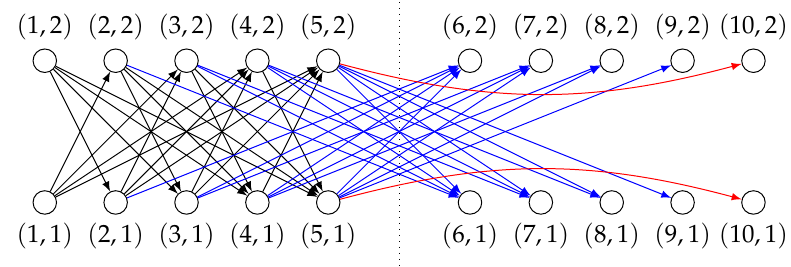
Figure 2. Graph A for CAP instance with n = 5 and m =